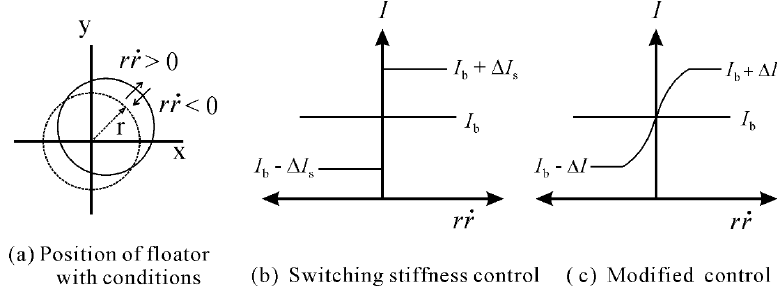
Figure 3. ( a ) Radial position with conditions, and profile of current: ( b ) switching stiffness control; ( c ) modified control.